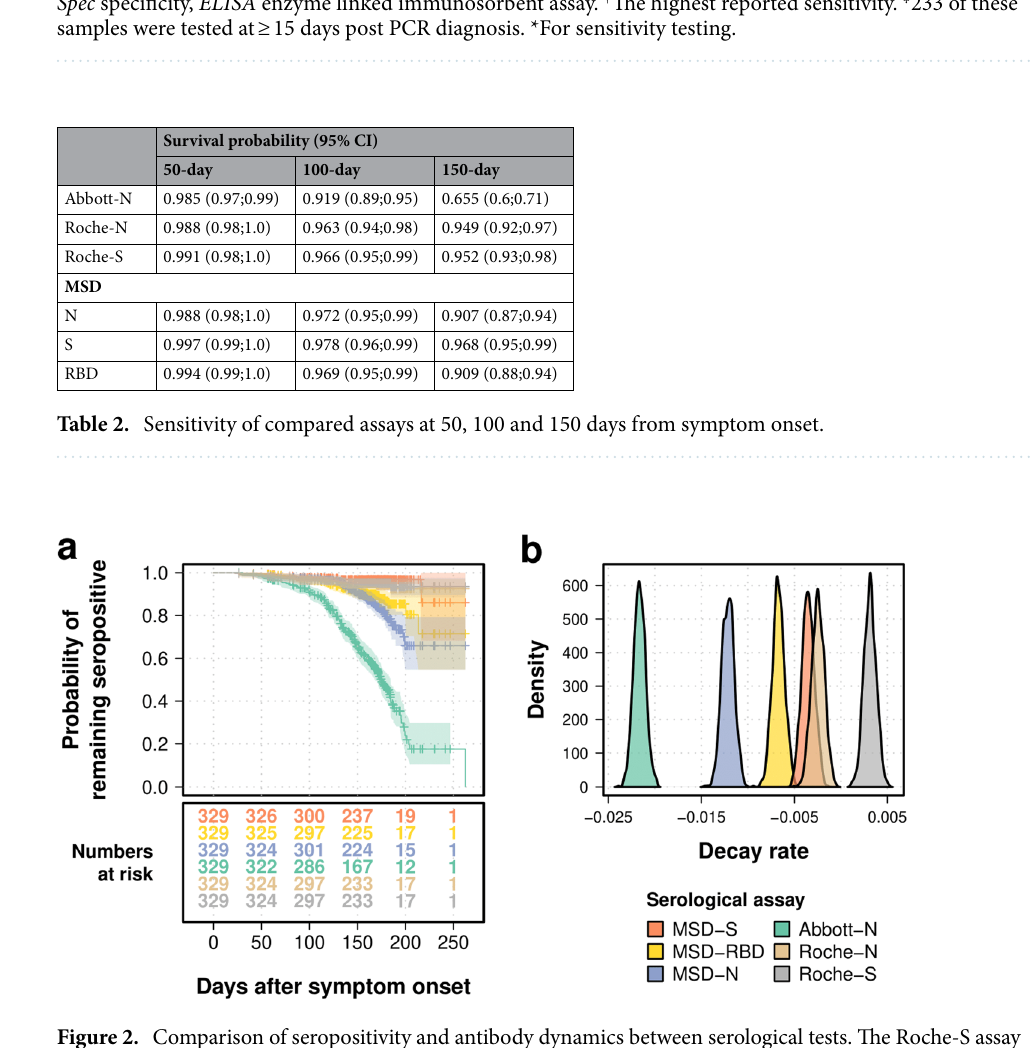
Figure 2. Comparison of seropositivity and antibody dynamics between serological tests. The Roche-S assay target the spike antibody, the Abbott-N and the Roche-N assays target the N-antibody while the MSD assay targets the N-, the S- and the antibody to the Receptor Binding Domain (RBD) of the spike protein in parallel. ( a ) Kaplan–Meier curve and numbers at risk (the number of participants under follow up with serological tests available for analysis at that time point) for different serological tests. Y-axis represents the probability of remaining seropositive, while the X-axis shows days after symptom onset with numbers of participants under follow up shown in the table below. ( b ) Inferred posterior density distributions of the decay rate in a generalized linear mixed